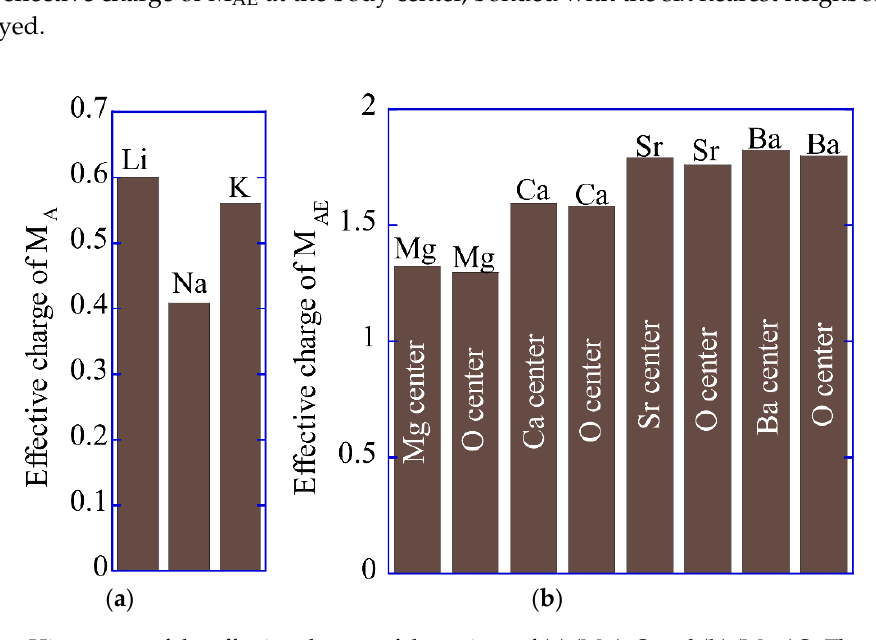
Figure 3. Histograms of the effective charges of the cations of ( a ) (M A ) 2 O and ( b ) (M AE )O. The values in Tables 3 and 4 were used. Table 4. E ff ective charge of M AE of the sodium chloride Table 4. Effective charge of M AE of the sodium chloride structures.